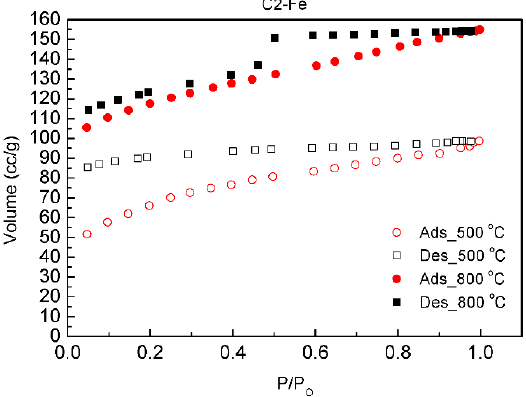
Figure 4. N 2 physisorption isotherms for sample C2-Fe pyrolyzed at 500 °C and 800 °C.